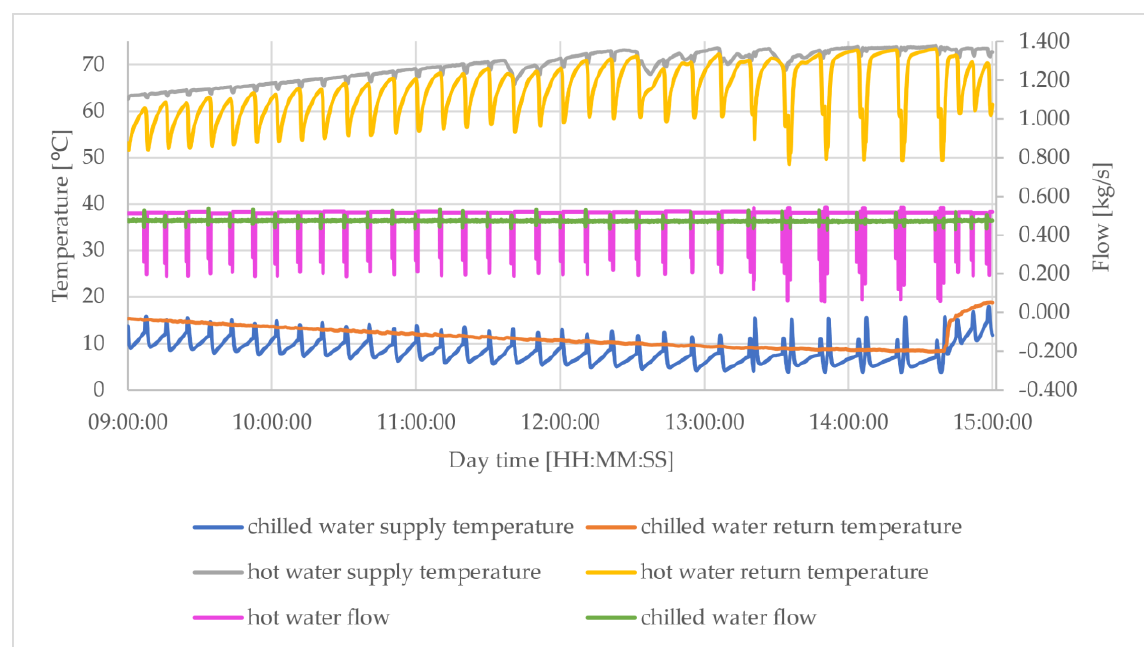
Figure 18. Measured values of temperatures and flow rates over time for 11th August.